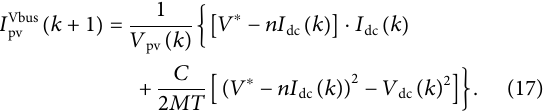
FIGURE 7 Flowchart of the reference selection